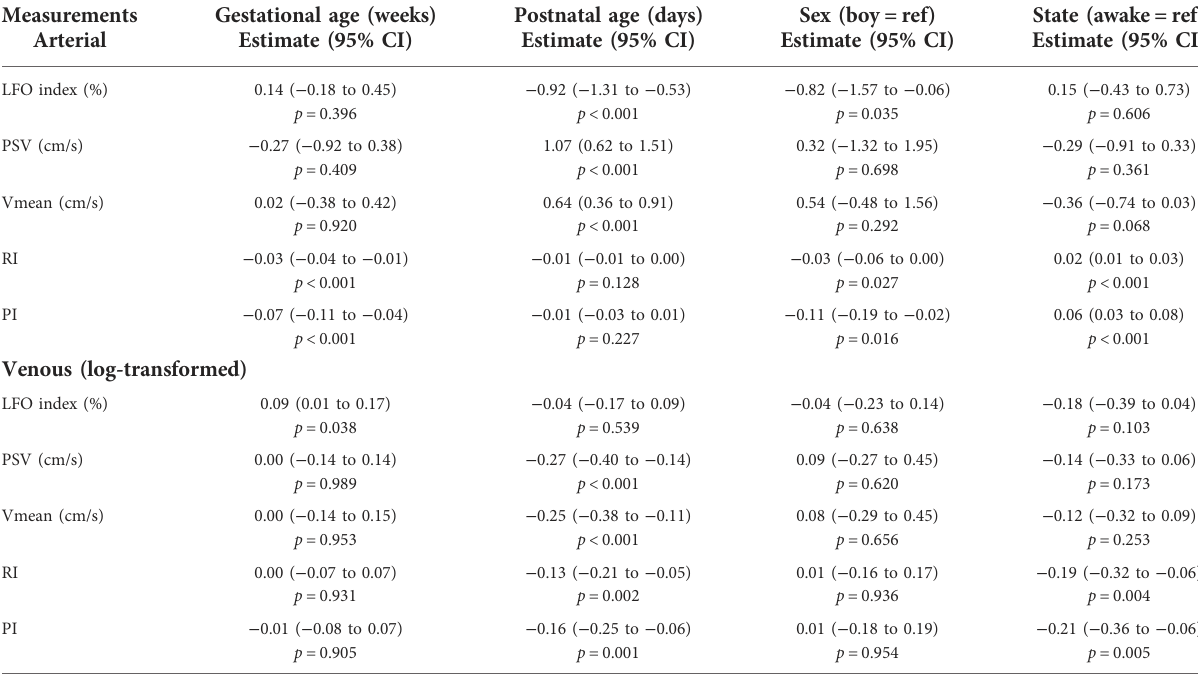
TABLE 3 Results from a linear mixed model to evaluate the association between cerebral hemodynamics and gestational age, postnatal age, sex, and behavioral state. Measurements